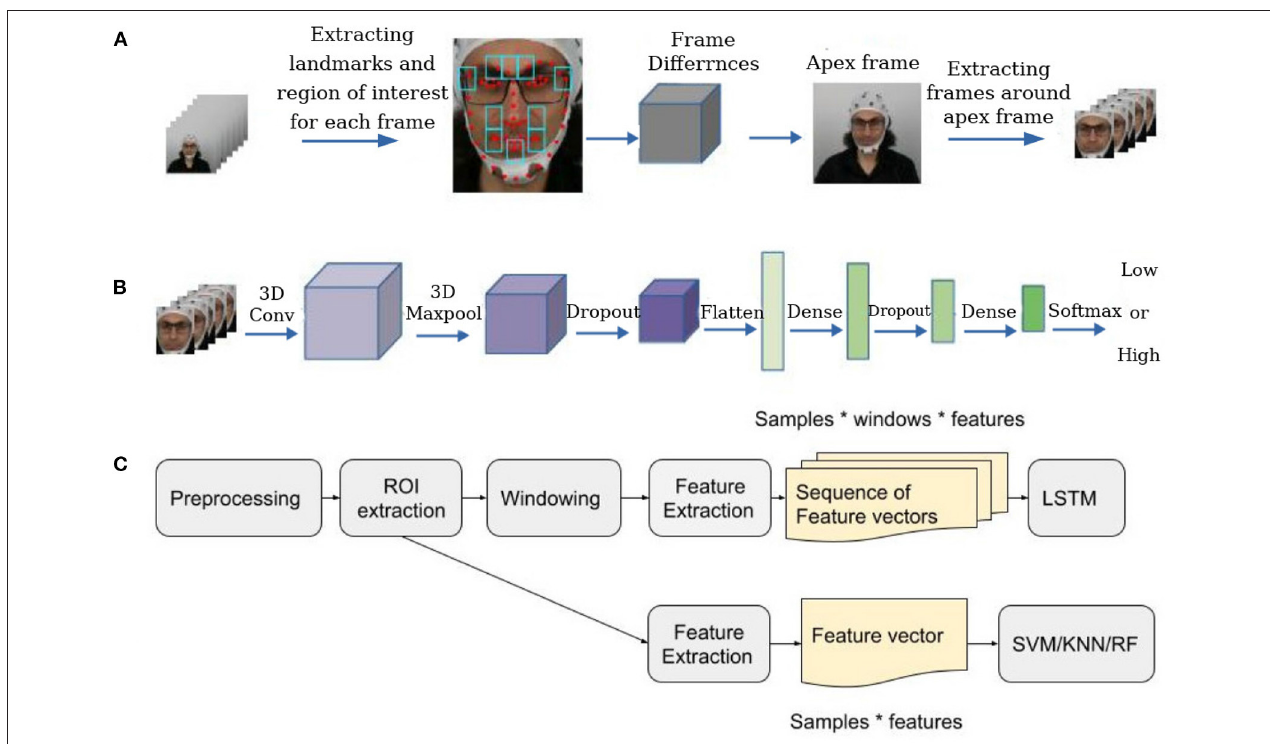
FIGURE 6 | Emotion recognition strategy. (A) Locating the apex frame in the sequence of all frames in each trial. (B) The architecture of the network for detecting arousal or valence states in facial videos based on micro-expressions. (C) The overall structure of EEG and physiological classification.